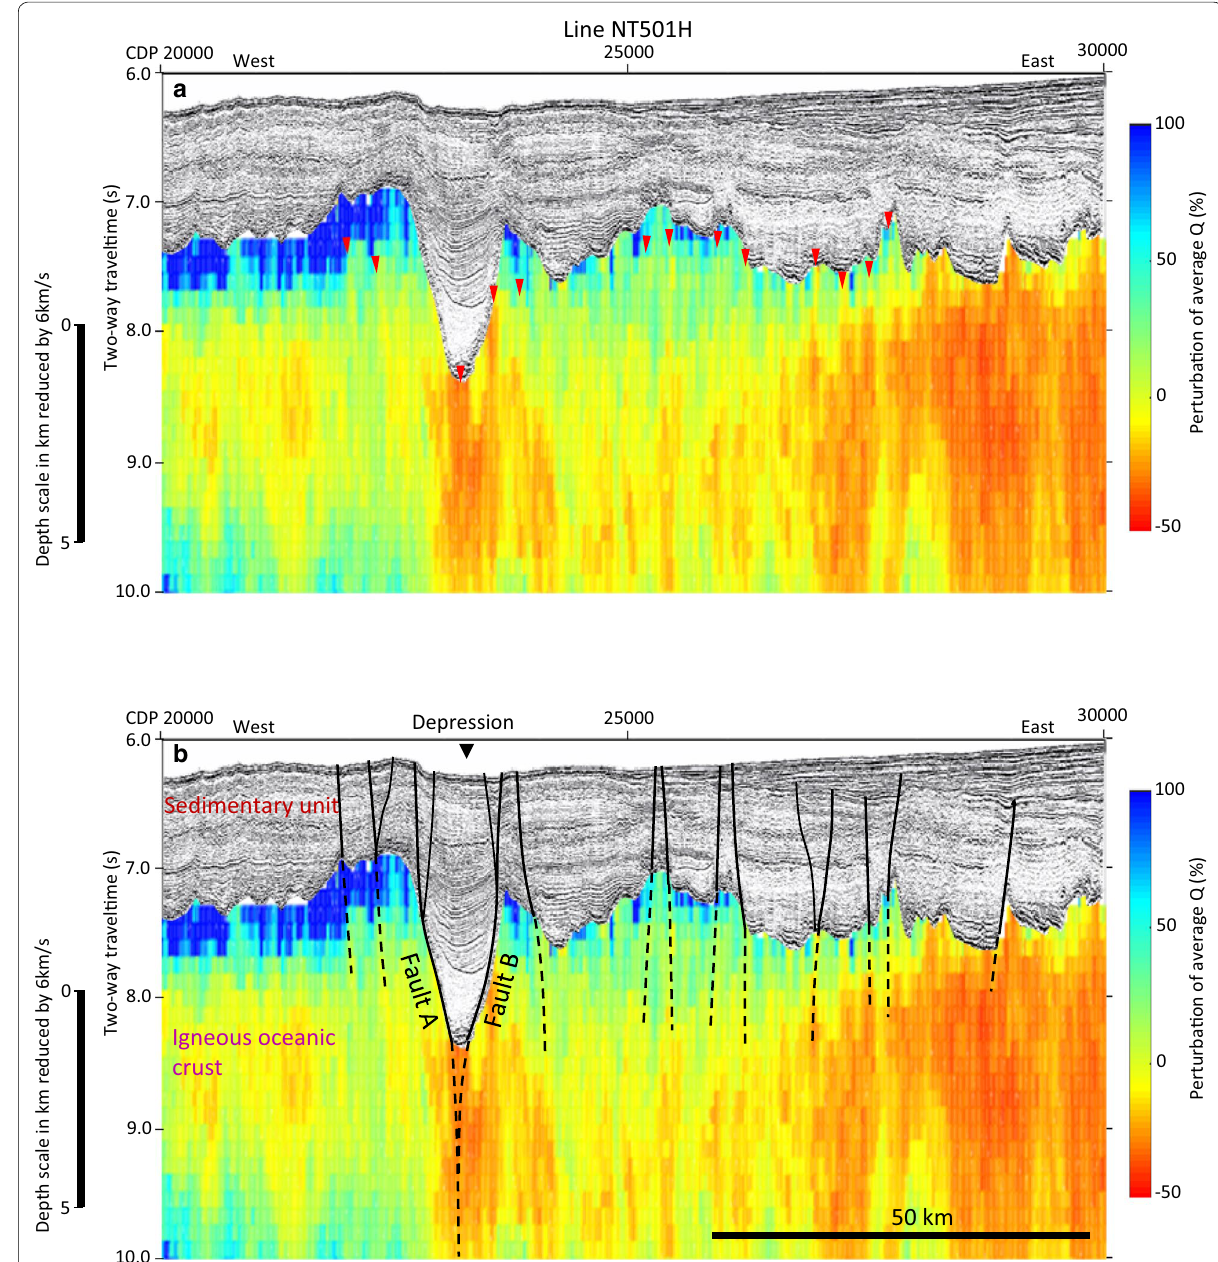
Fig. 10 Enlarged composite profile of conventional seismic reflection and attenuation profiles without fault interpretation ( a ) and with fault inter‑ pretation ( b ). Seismic reflectivity is effective for imaging geologic structures and faults in the sediments, whereas seismic attenuation is effective for imaging faults in the igneous oceanic crust. Red inverted triangles denote the locations of high‑attenuation